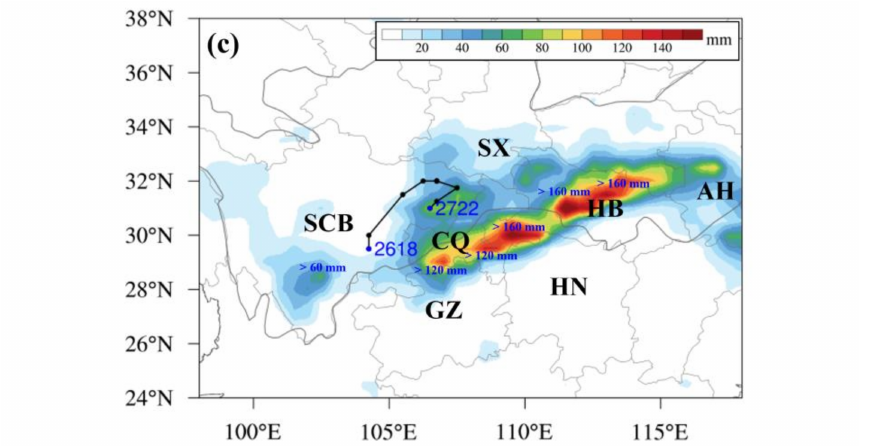
Figure 1. Panel ( a ) illustrates the accumulated precipitation (shading dots, units: mm) associated with mesoscale vortices at the ground observational stations (dots) in the YRV, during the 2020 Meiyu season. Panel ( b ) shows the temporal mean (from 1800 UTC 26 to 2200 UTC 27 June 2020) stream field, vorticity (shading, units: 10 − 5 s − 1 ), and wind exceeding 12 m s − 1 (a full bar represents 4 m s − 1 ) at 750 hPa, where the grey shading outlines terrain higher than 2500 m and the thick red dashed line shows the lower-level shear line. Panel ( c ) illustrates the 28-h accumulated precipitation (shading, units: mm) and the track of the SWV (black solid line with black dots, where the blue dots mark the formation and dissipation locations). SCB = Sichuan Basin; SC = Sichuan, CQ = Chongqing, HB = Hubei, HN = Hunan, GZ = Guizhou, AH = Anhui, and SX =